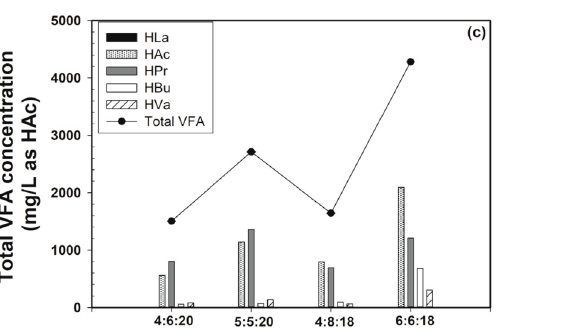
Figure 7. Effect of the bioreactor volumetric ratio on the total VFA concentration and VFA composition of the ( a ) first, ( b ) second and ( c ) third bioreactors when the three - stage ASBR system was operated at a COD loading rate of 18 kg / m 3 d, 37 °C and 8 cycles / d .